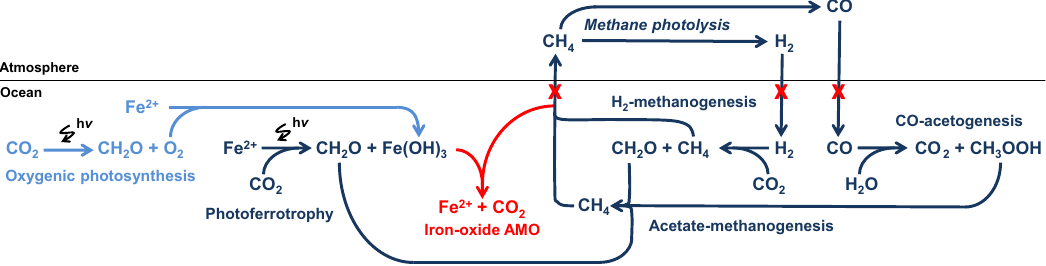
Figure 6. Potential role of iron-oxide AOM in Archean Ocean metabolism. In the Archean Ocean, anaerobic metabolism (photoferrotrophy, methanogenesis and CO-acetogenesis in dark blue) dominated before the advent of oxygenic photosynthesis (in light blue). In red, we propose anaerobic methane oxidation (AOM) using Fe oxides as electron acceptor as additional metabolic process. Before the advent of oxygenic photosynthesis, Fe 3+ dependent AOM linked photoferrotrophy and H 2 -methanogenesis that so far have been seen as two parallel and unconnected processes. After the advent of oxygenic photosynthesis, Fe oxides-dependent AOM might have used the abundantly produced Fe(OH) 3 from the oxidation of Fe 2+ by O 2 to further remove CH 4 from the water column, facilitating the increase of O 2 in the atmosphere and the great oxidation